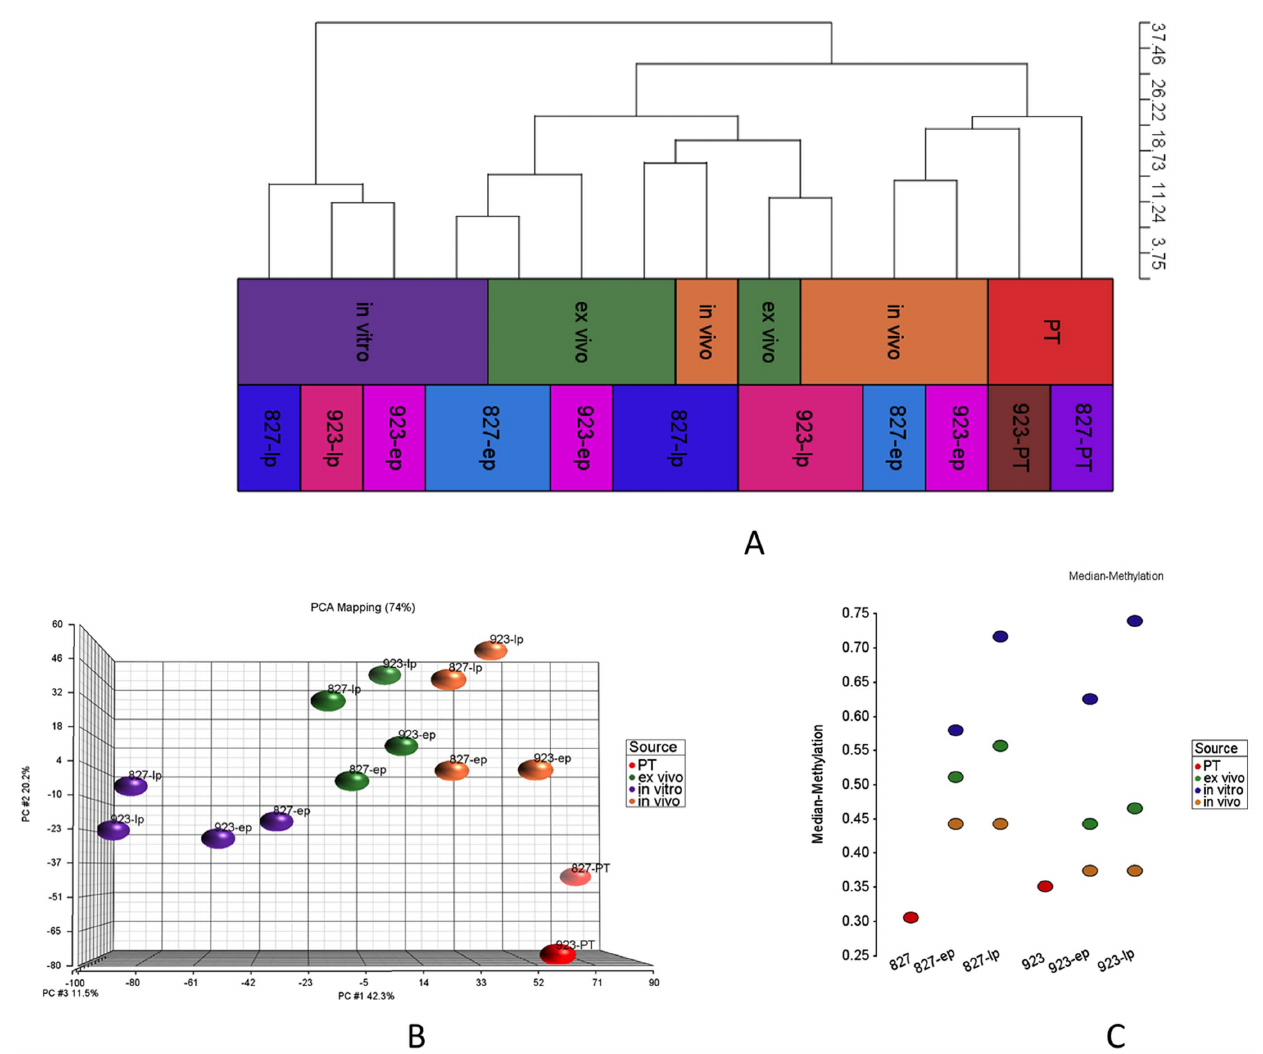
Figure 3. DNA methylation profiles of patient tumors and invitro , invivo , exvivo GSCs for two cell lines. (A,B) HC and PCA for PT, in vitro , in vivo and ex vivo samples for early and late passages (ep, lp). 6825 sites with standard deviation greater than 0.15 are presented. These sites are not differentially methylated between 827 and 923 (Mann-Whitney p-value more than 0.5). (C) Median methylation values for each sample based on selected 6825